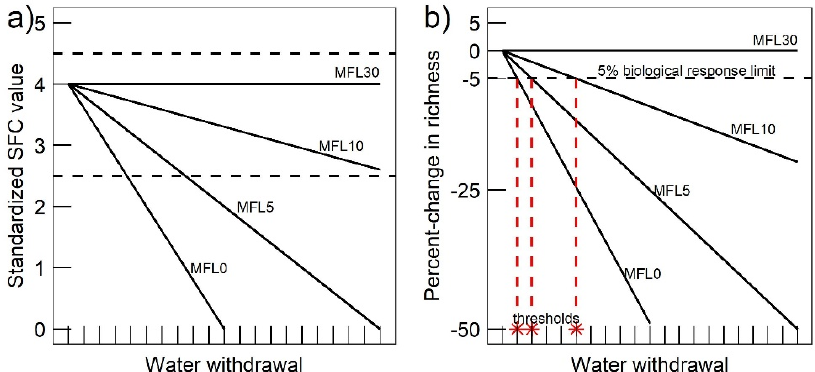
Figure 3. Hypothetical responses of ( a ) SFC values and ( b ) percent-changes in species richness plotted for a single stream site across increasing water-withdrawal scenarios and for different minimum flow levels (solid lines). ( a ) Dashed horizontal lines represent the pre-defined interquartile range of SFC responses among reference sites. ( b ) Dashed horizontal line represents an arbitrary biological response limit; Dashed red vertical lines represent intersection points at which an ecological withdrawal threshold occurs, i.e., at which a 5% loss of species richness occurs.